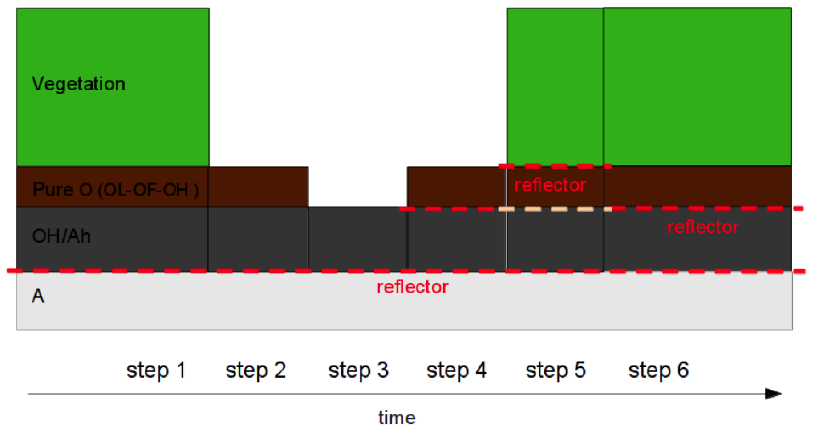
Figure 4. Sketch of the different measurement configurations during the layer experiment.